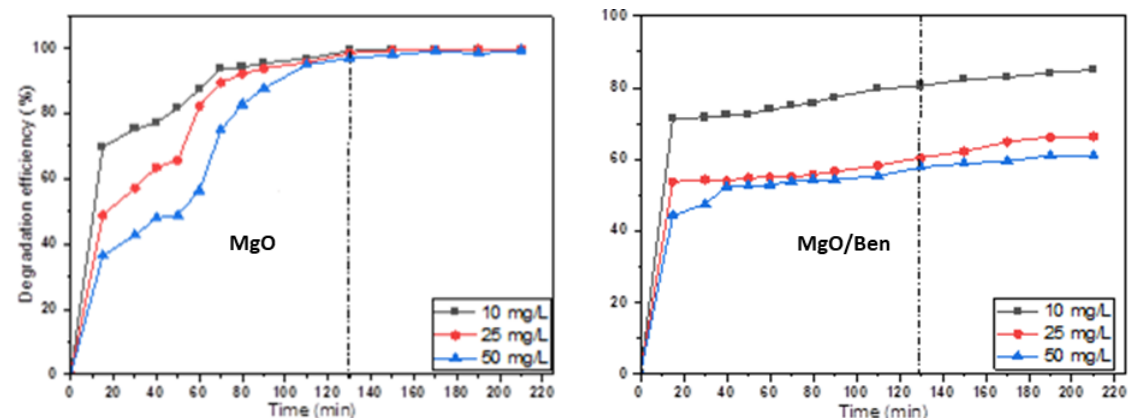
Figure 12. Effect of different initial dye concentrations on the photocatalytic degradation of CV using MgO NPs MgO/Ben nanocomposite.